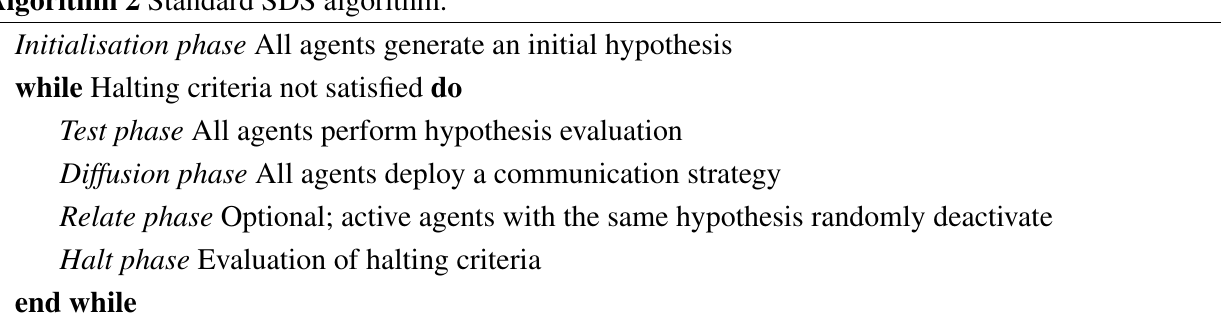
Algorithm 2 Standard SDS